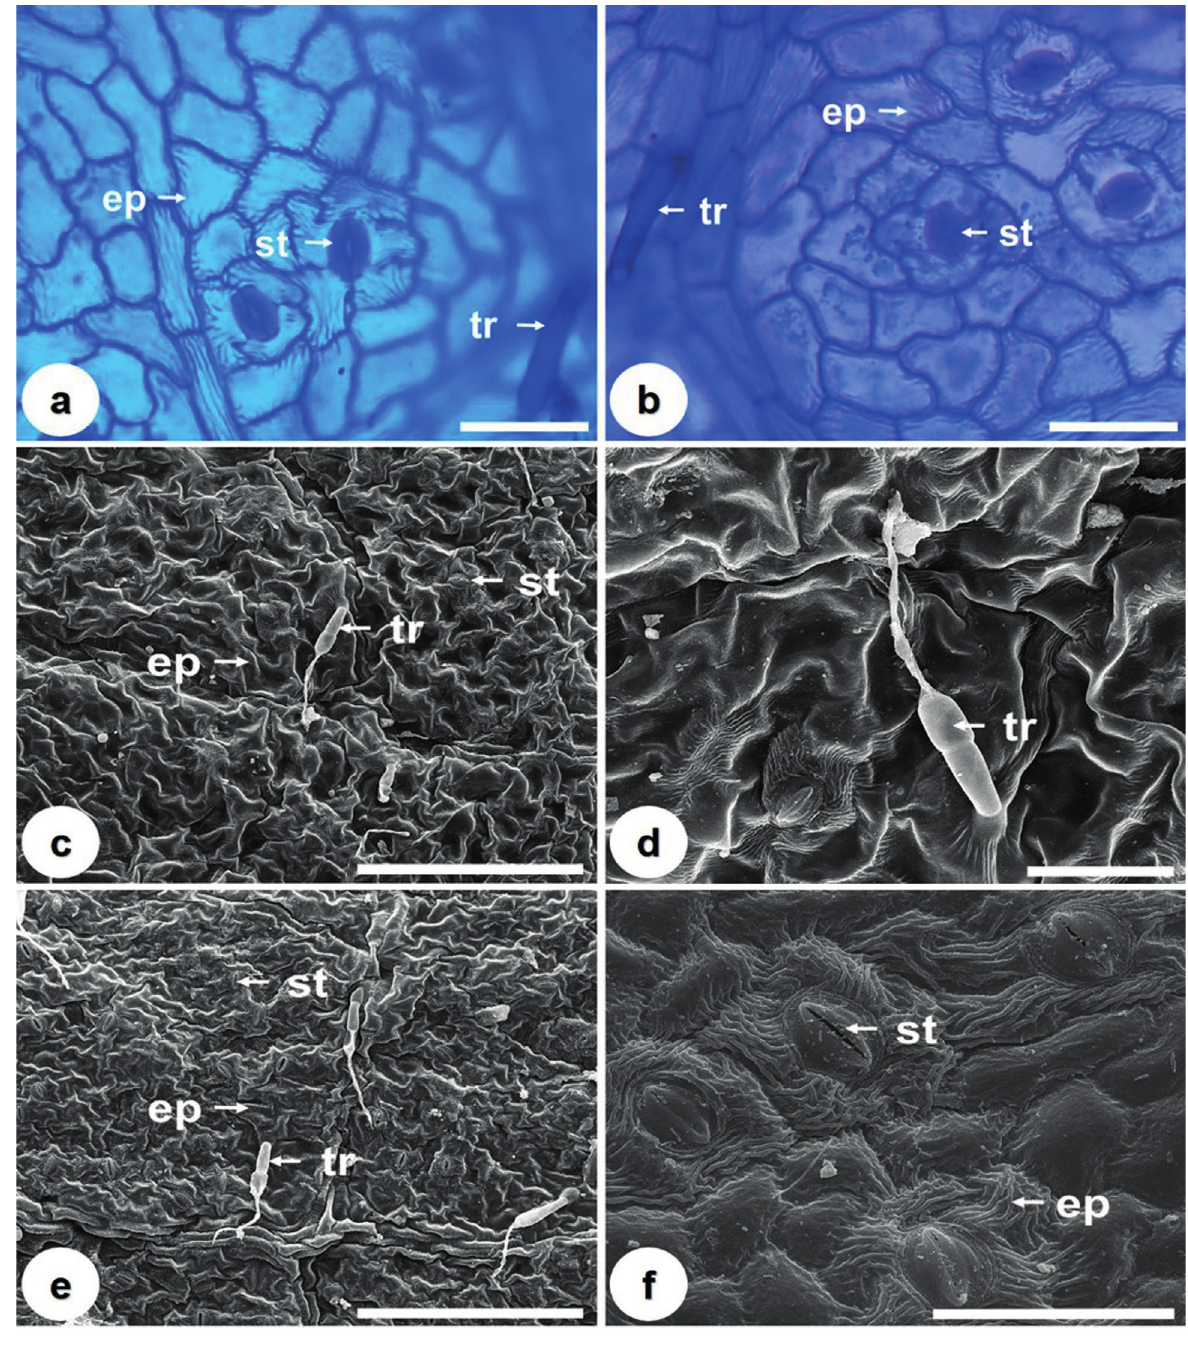
Figure 2 - Solidago chilensis Meyen (Asteraceae), paradermal sections and SEM of the leaf. (a) Adaxial face, showing epidermal cells (ep) coated by striated cuticle, stomata (st) and non-glandular trichome (tr). (b) Abaxial face, where are visualized epidermal cells (ep) coated by striated cuticle, stomata (st) and non-glandular trichome (tr). C-F: SEM of the leaf. (c) View of the adaxial face showing epidermal cells (ep), stomata (st) and non-glandular trichome (tr) (d) Detail of the non-glandular trichome (tr) on adaxial face. (e) View of the abaxial face showing epidermal cells (ep), stomata (st) and non-glandular trichome (tr) (f) Detail of epidermal cells (ep) coated by striated cuticle and stomata (st) on abaxial face. Bars: a , b , d and f = 50 µm; c and e = 200